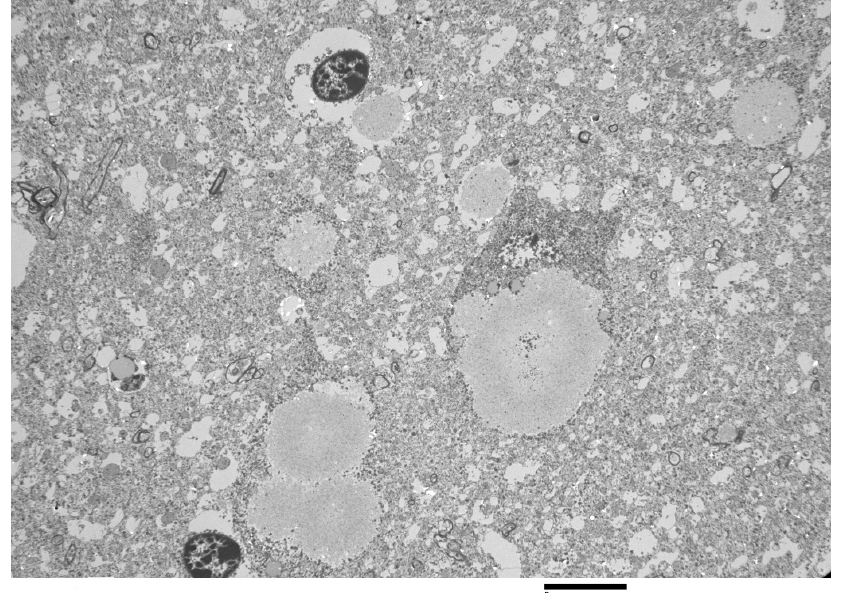
Figure 6. Low-power electron micrograph of the perikaryon with polyglucosan bodies (PGBs) in neurons of the hippocampus of the same moose. Electron-dense core is the equivalent of the basophilic core seen in H&E-stained material.